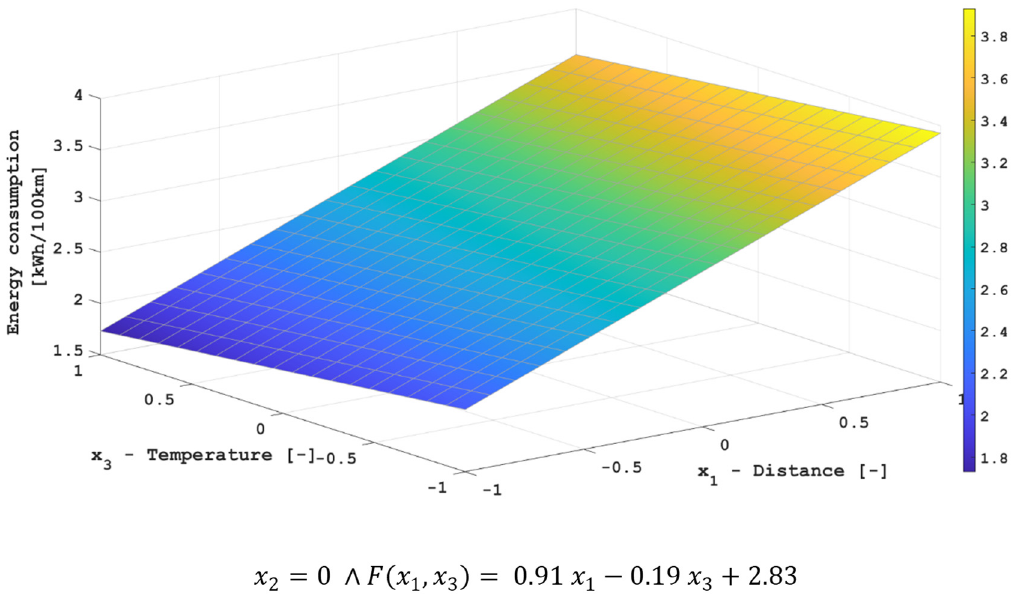
Figure 7. The energy demand of the scooter when covering the route in 45 min.